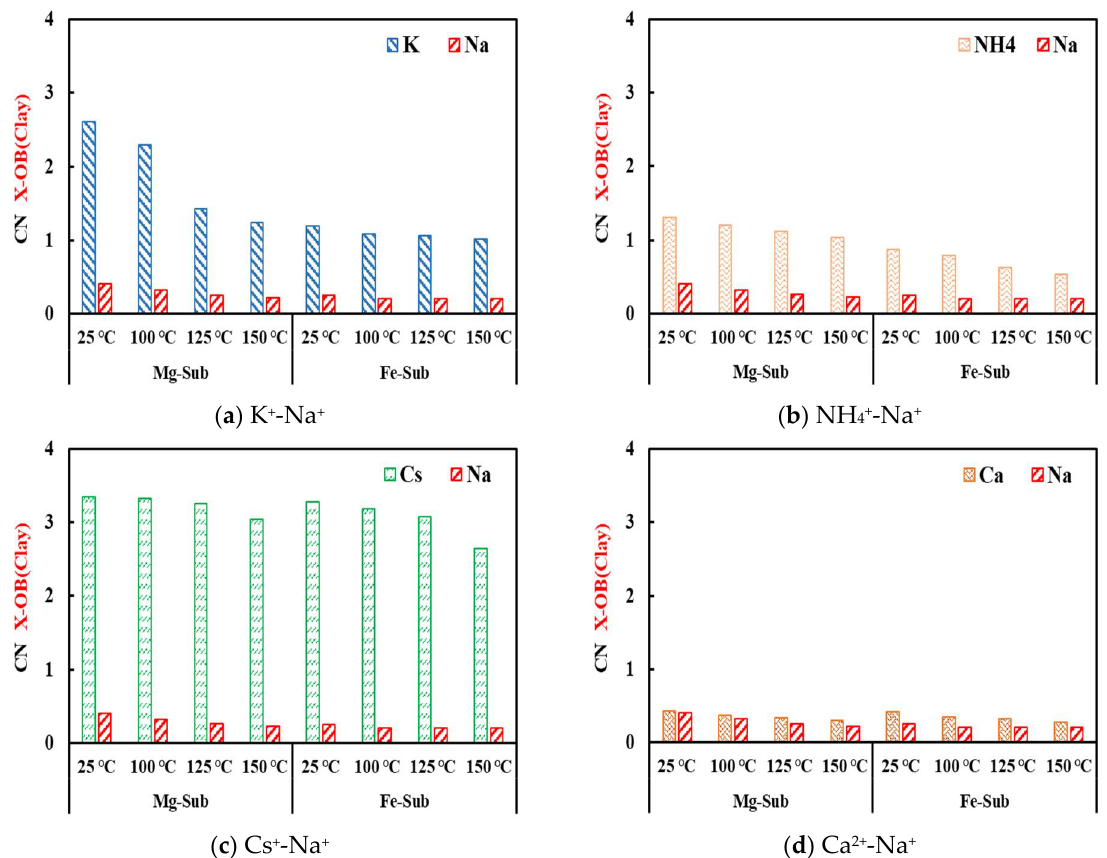
Figure 8. CN of counterions and O in silicon–oxygen tetrahedron surface under different counterions and temperatures.